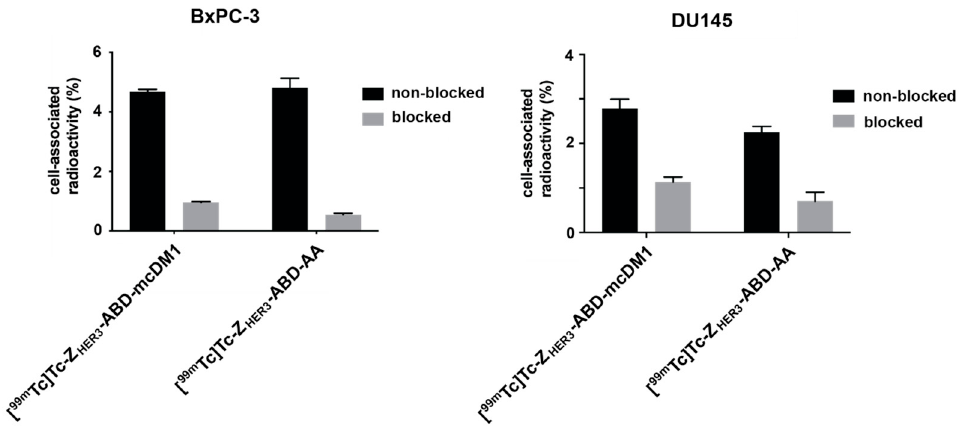
Figure 4. Cell-binding specificity of [ 99m Tc]Tc-Z HER3 -ABD-mcDM1 and [ 99m Tc]Tc-Z HER3 -ABD-AA. BxPC-3 or DU145 cells were pre-incubated (blocked) with Z HER3:08698 or not pre-incubated (non- blocked). The concentration of the construct for pre-blocking was 50 nM. Subsequently, the cells were incubated with [ 99m Tc]Tc-Z HER3 -ABD-mcDM1 or [ 99m Tc]Tc-Z HER3 -ABD-AA (0.1 nM). Both panels added. The results are shown as the average of three samples with the error bars corresponding